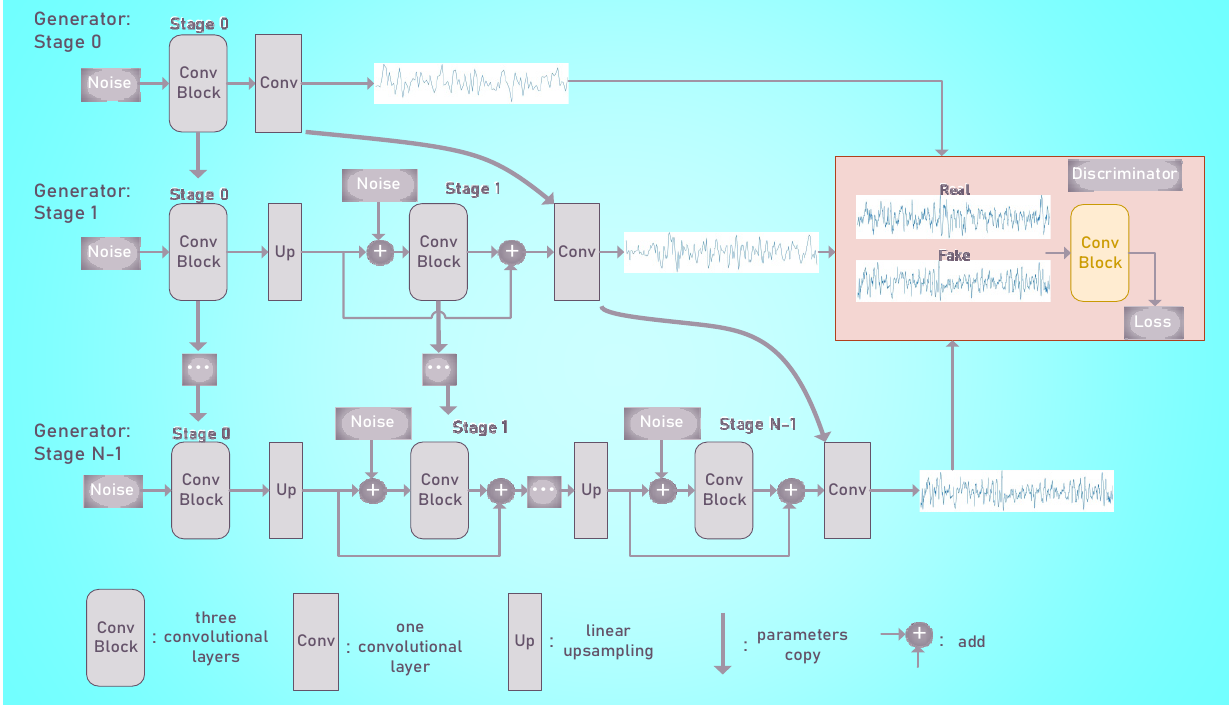
Figure 3. An overview of a model of EEG epochs generation. The training starts at stage 0 with a small generator and small sample resolution. With increasing stages, both the generator capacity and the sample resolution increase. Gaussian noise is used as additional noise.